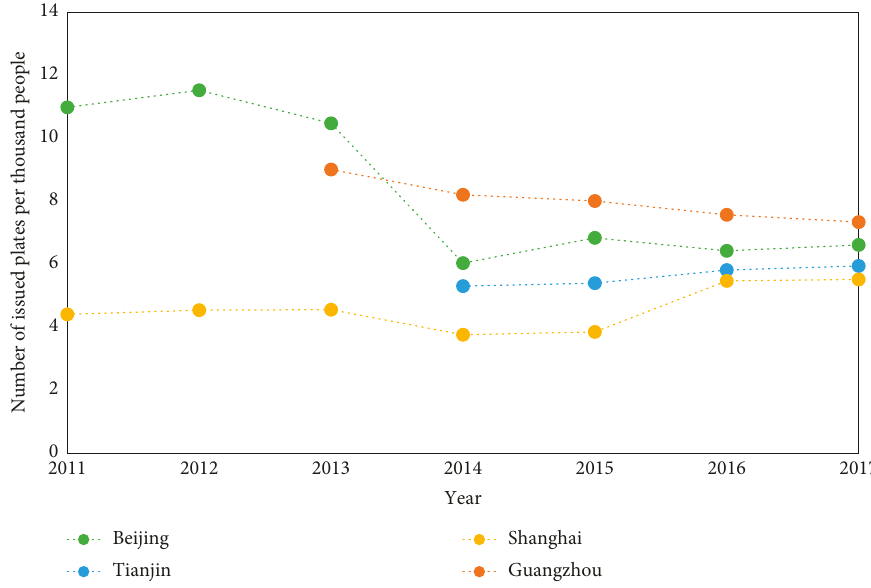
Figure 10: The number of issued plates per thousand people in Beijing, Tianjin, Shanghai, and Guangzhou.